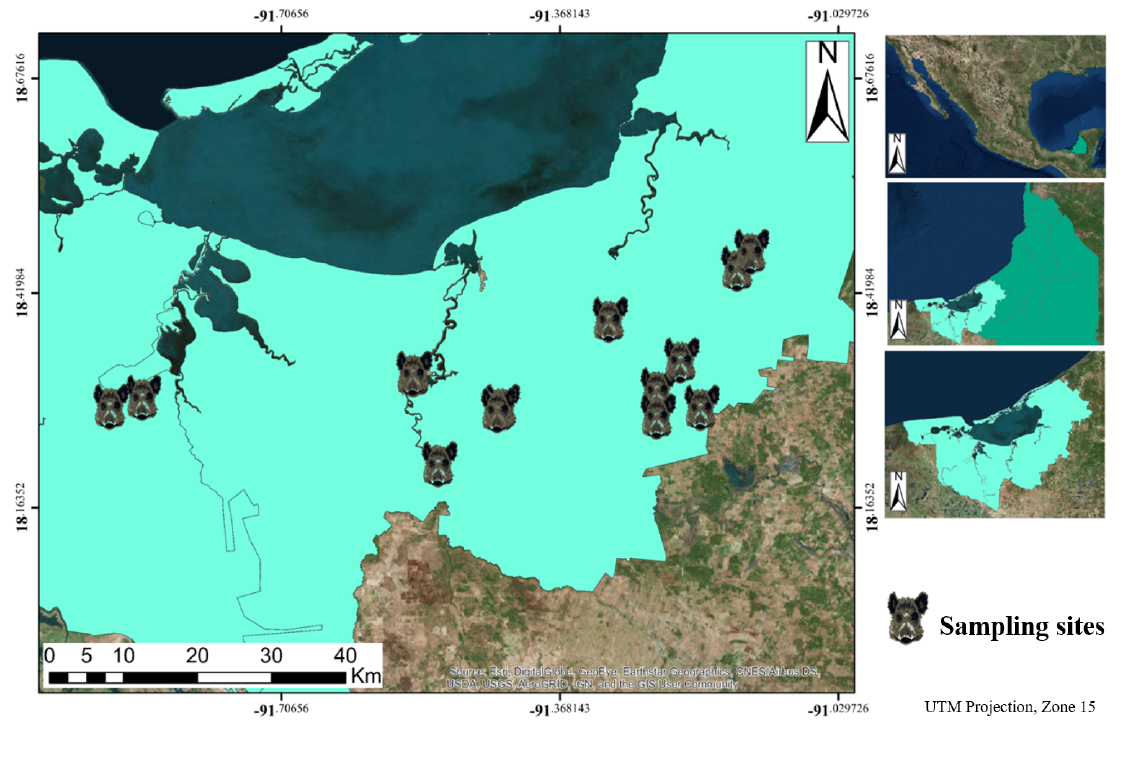
Figure 1. Area under study and sampling sites. Hog heads show sampling sites around the